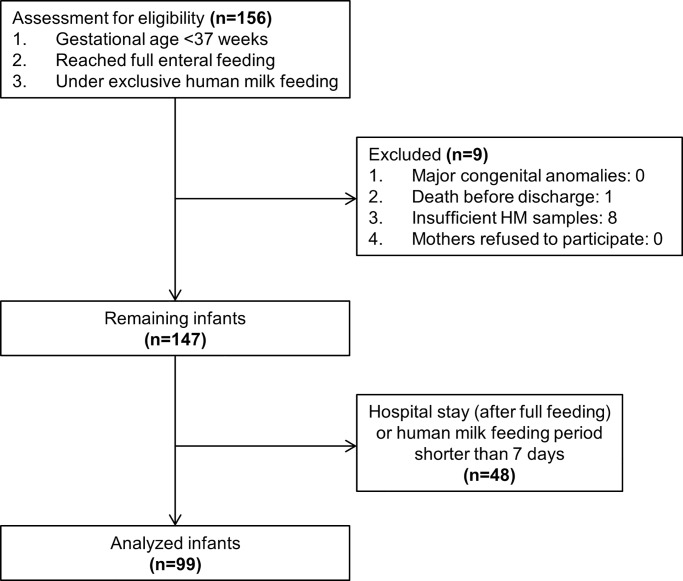
Participant flow through the trial.